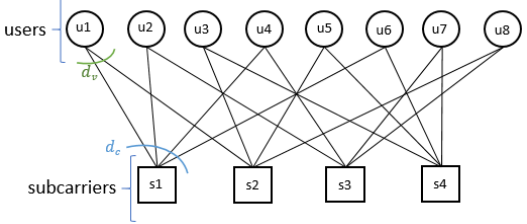
Figure 2. Spreading process of LDS-UFMC